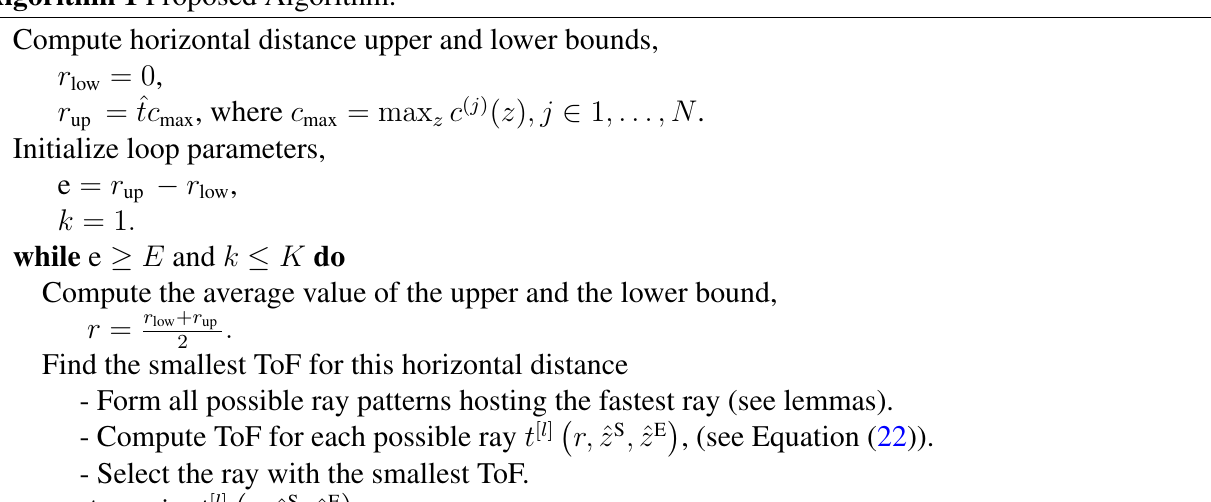
Algorithm 1 Proposed